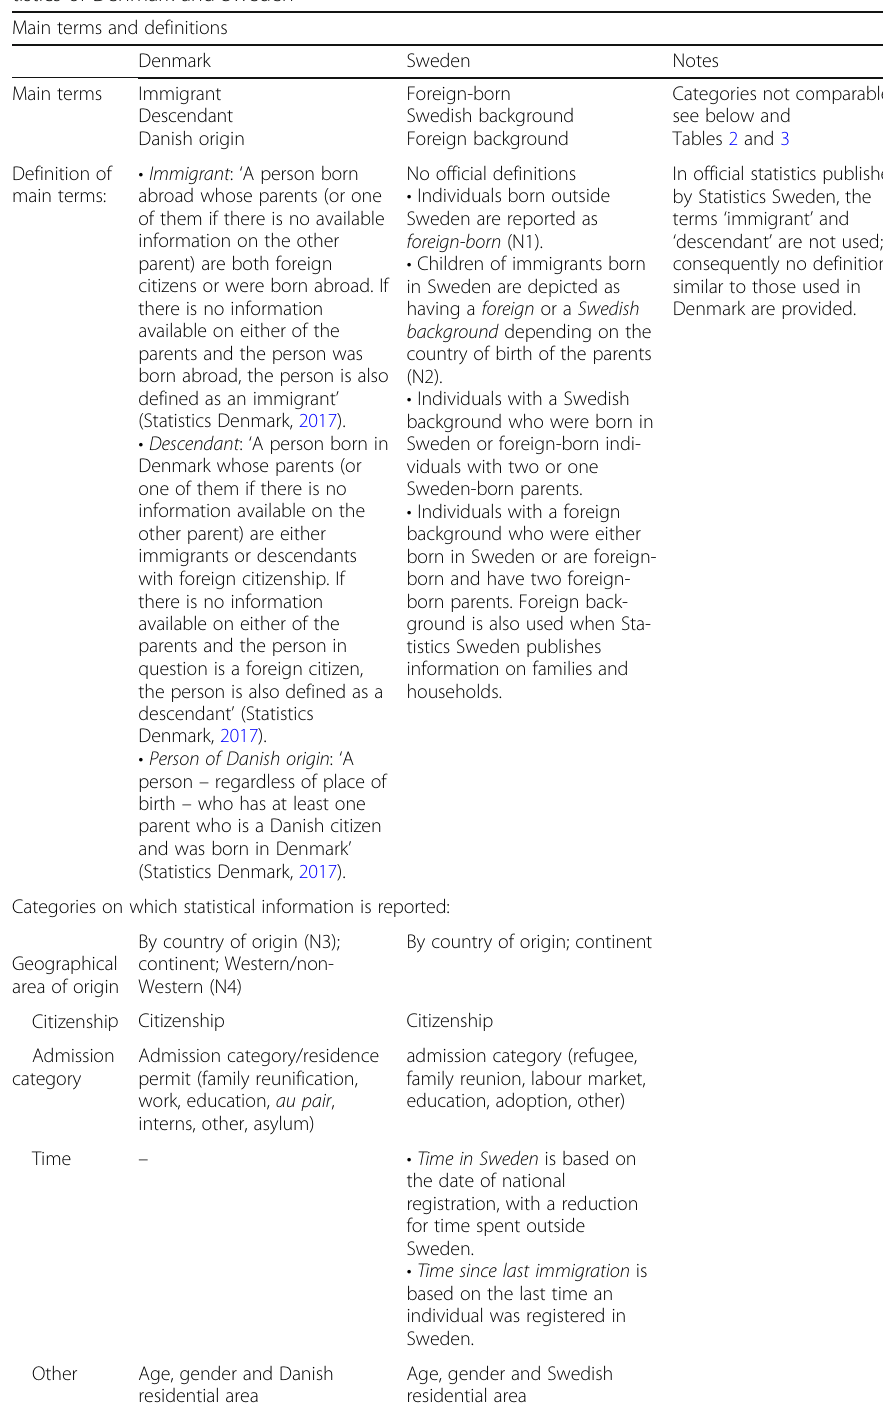
Table 1 Main terms and categories used to report on the non-native population in the official sta- tistics of Denmark and